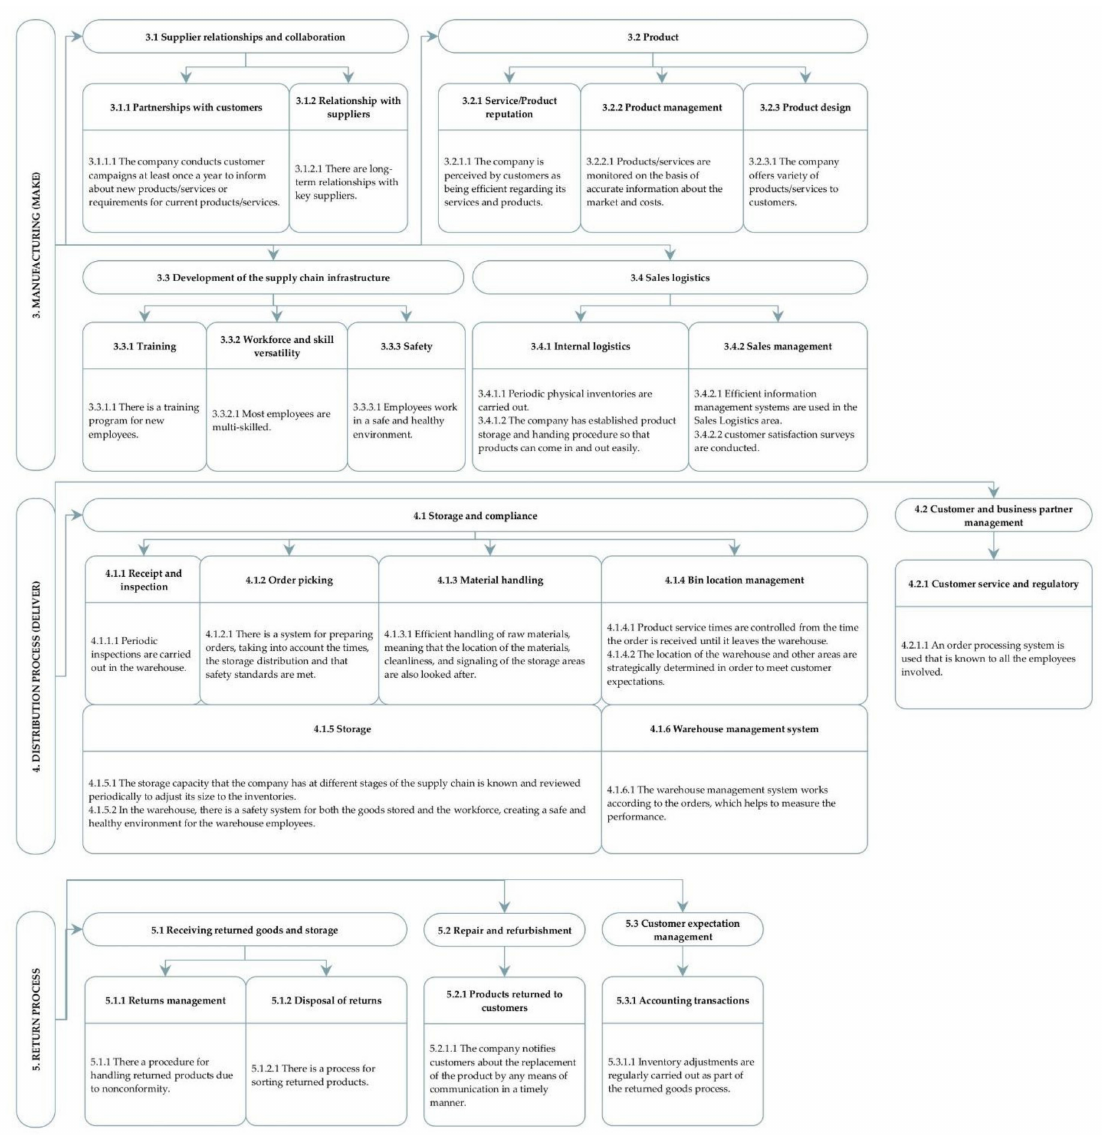
Figure 2. Disaggregation of the SCOR model’s supply chain main processes into sub-processes, activities, and tasks. Source: Authors’